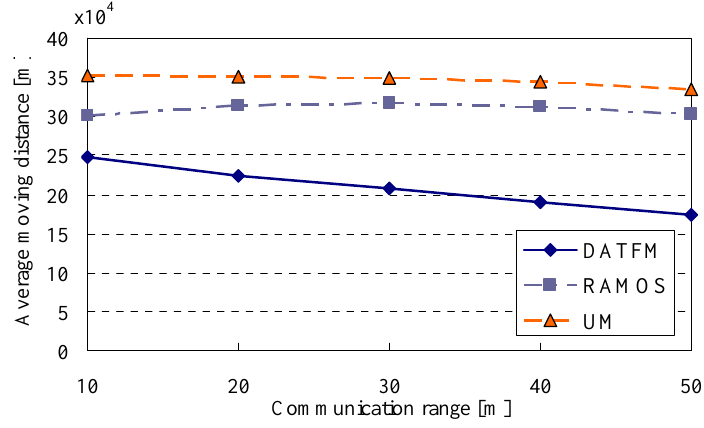
Figure 17. Communication range and average moving